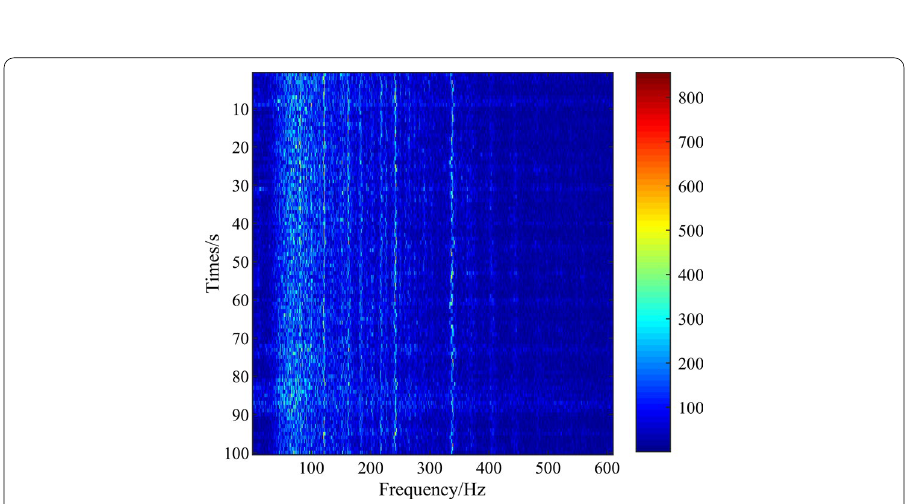
Fig. 19 Original lofargram of second set of sea-trial